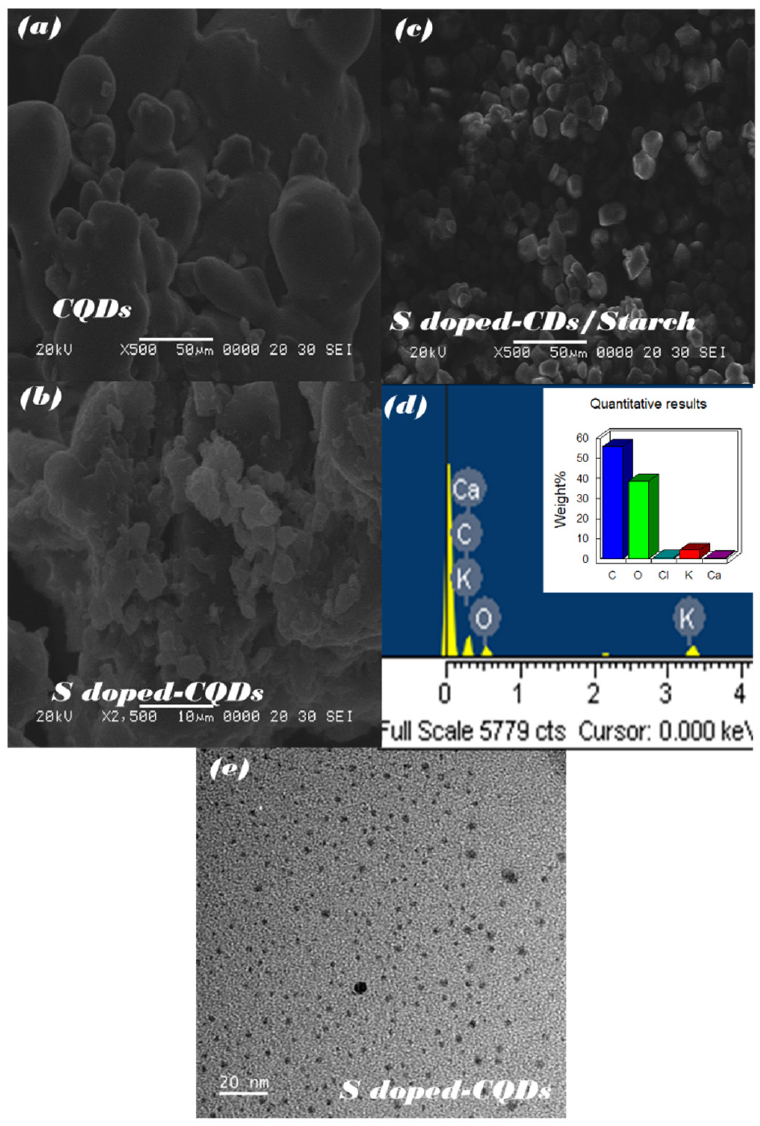
Figure 4. FIB-SEM of ( a ) CQDs, ( b ) S-CQDs, and ( c ) S-CQDs/starch; EDX of ( d ) S-CQDs; TEM of ( e ) CQDs.